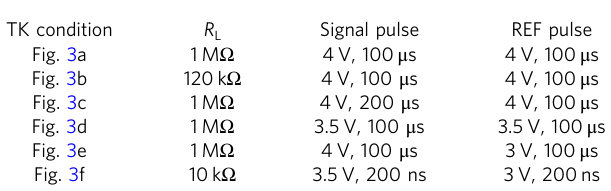
Table 1 The temporal kernel conditions (RL, signal pulse, and REF pulse) used in Fig. 3a – e.